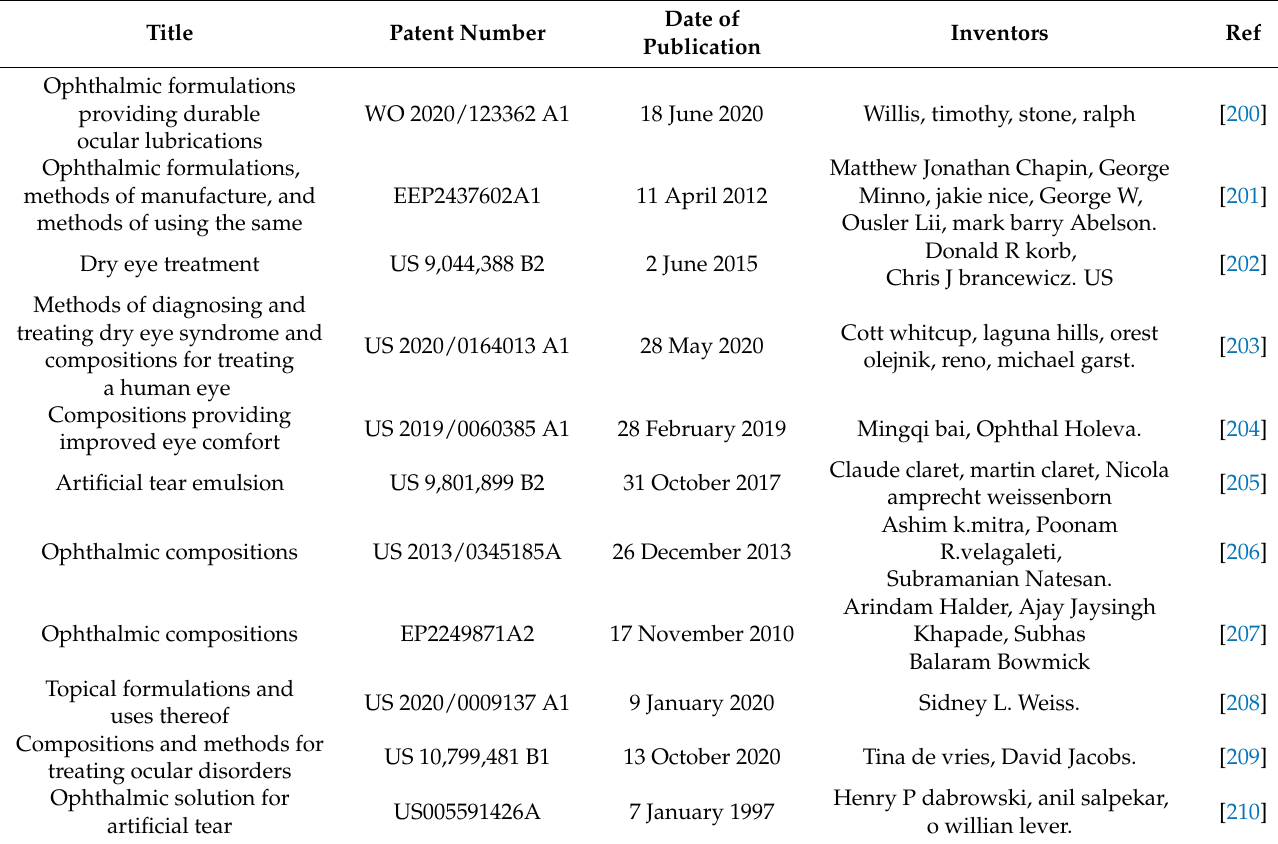
Table 8. Patents on various cellulosic polymers used for ophthalmic